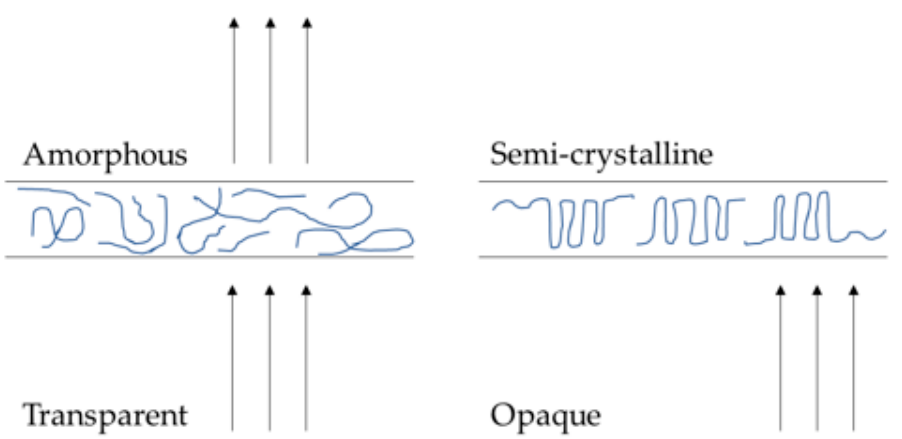
Figure 3. The more highly-organised polymeric structure found within semi-crystalline polymers can disrupt the transmission of light rays, rendering the material opaque.